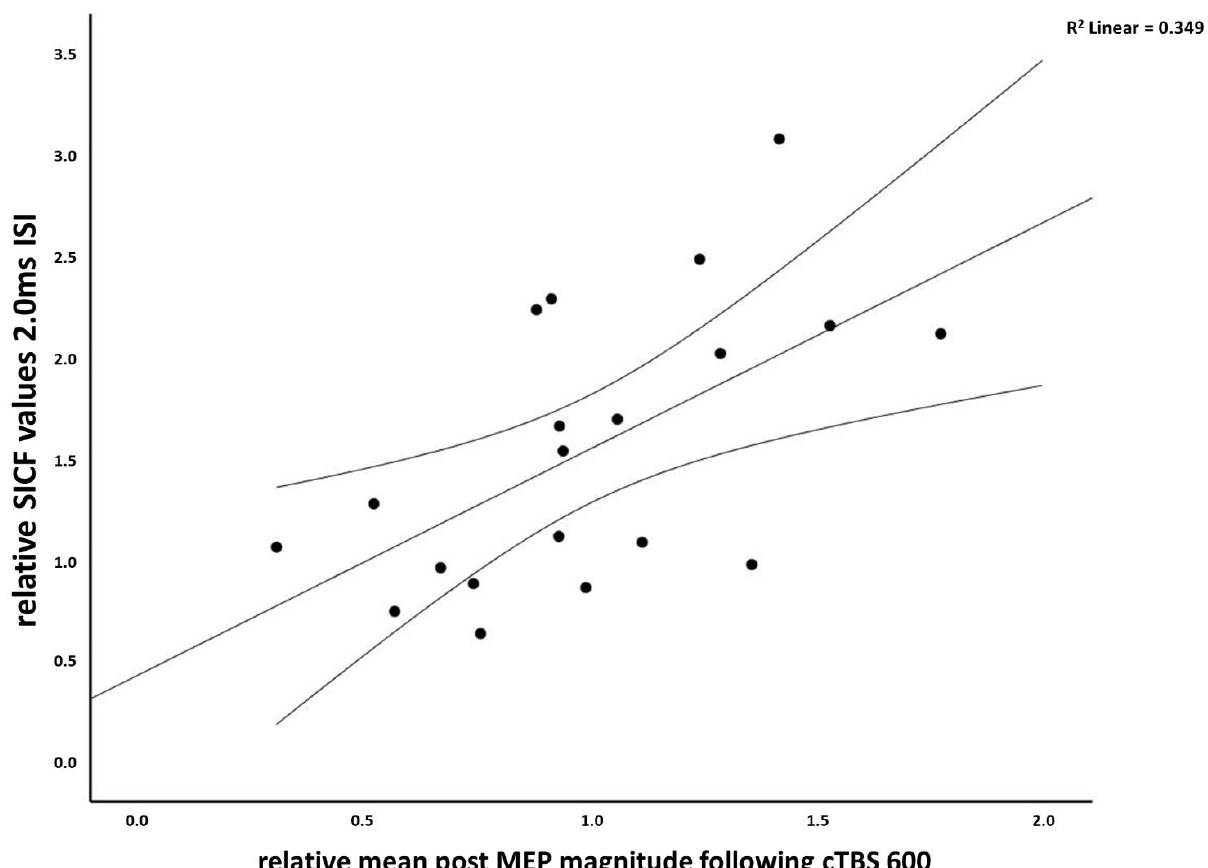
Figure 4. Pearson correlational coefficient between relative mean post MEP magnitudes following cTBS 600 and relative SICF values at ISI 2.0 ms (r = 0.591, p = 0.006) including mean 95% confidence intervals.